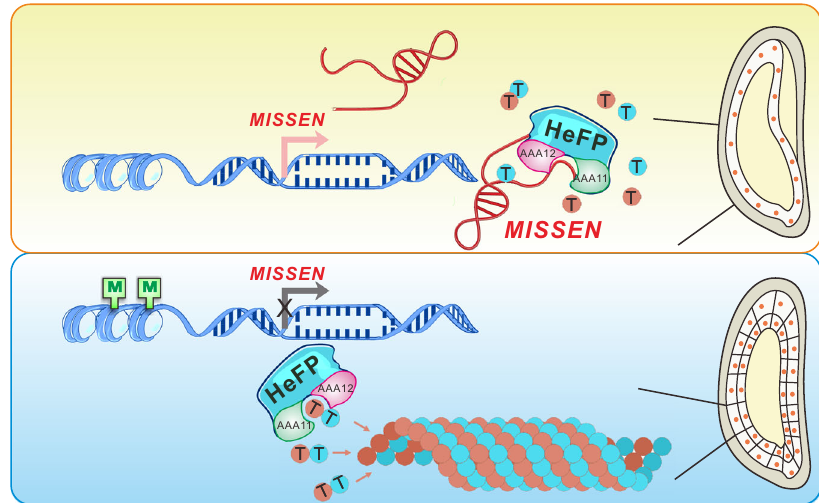
Fig. 8 The working model of MISSEN during endosperm development. MISSEN competitively inhibited the interaction between HeFP and tubulin. The transcription of MISSEN is turned off by H3K27me3 modi fi cation during endosperm